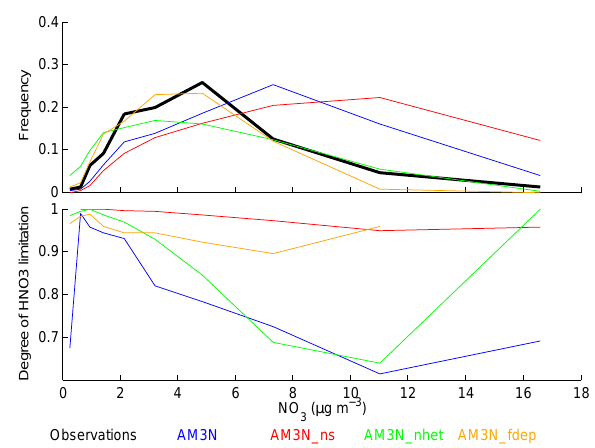
Figure 4. Observed and simulated distribution of daily NO − centration at Bondville (40.1 ◦ N, 88.4 ◦ W) in winter (top panel) from 2006 to 2012 (observations) and 2008 to 2010 (model). The degree of HNO 3 limitation for NH 4 NO 3 formation (GR > 1) is shown in the bottom panel. The different model sensitivity exper- iments are described in Table